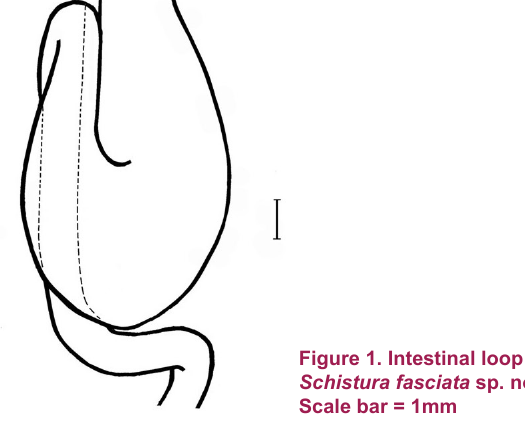
Figure 1. Intestinal loop of Schistura fasciata sp. nov. Scale bar =